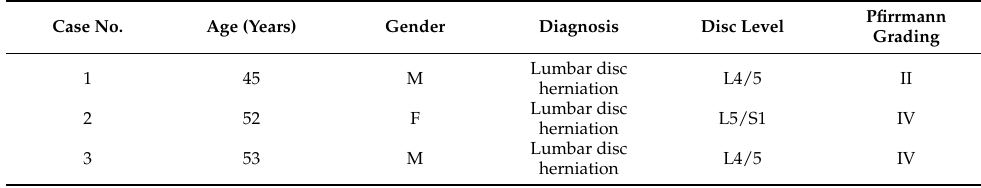
Table 1. Summary of patients’